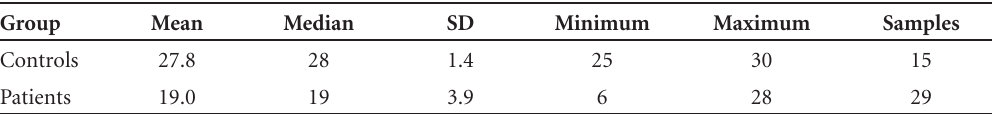
Table 1. MMSE Scores in patients and